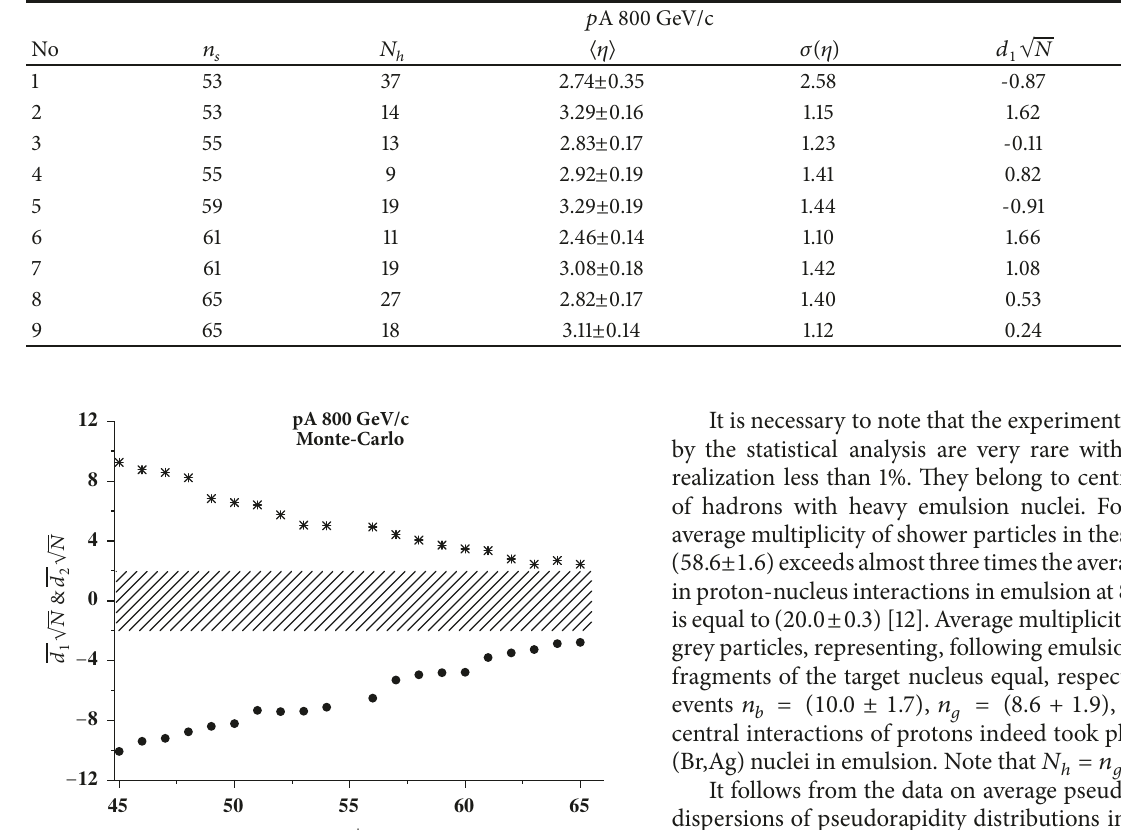
Table 1: Characteristics of 9 events selected by the statistical approach from proton-nucleus collisions.